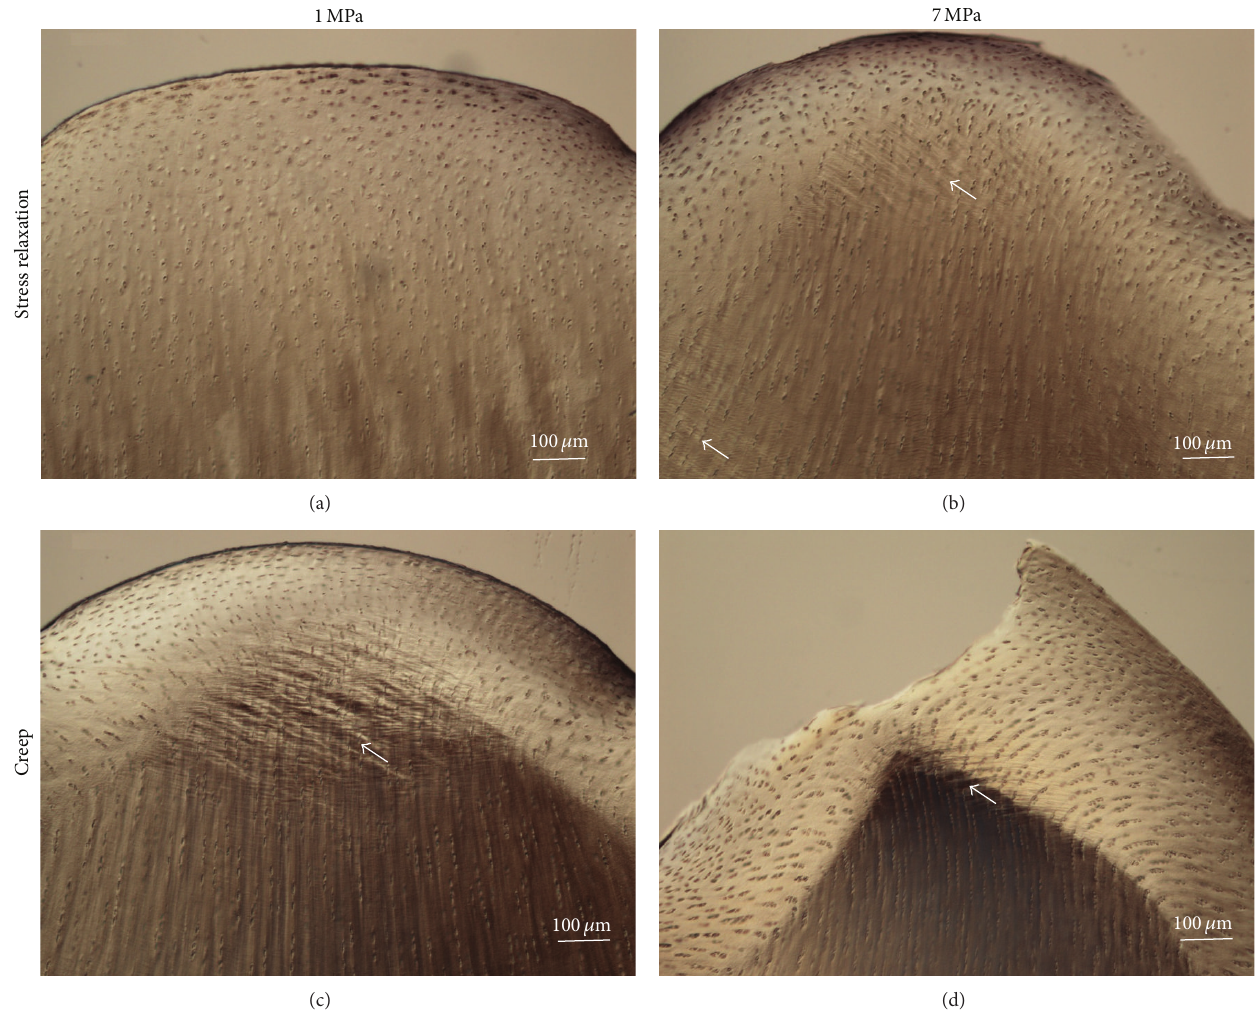
Figure 4: Differential interference contrast (DIC) images of the bulge region from typical samples of the four groups studied: (a) SR1, (b) SR7, (c) Cr1, and (d) Cr7, where rupture has occurred. The arrows point to visible shear bands.